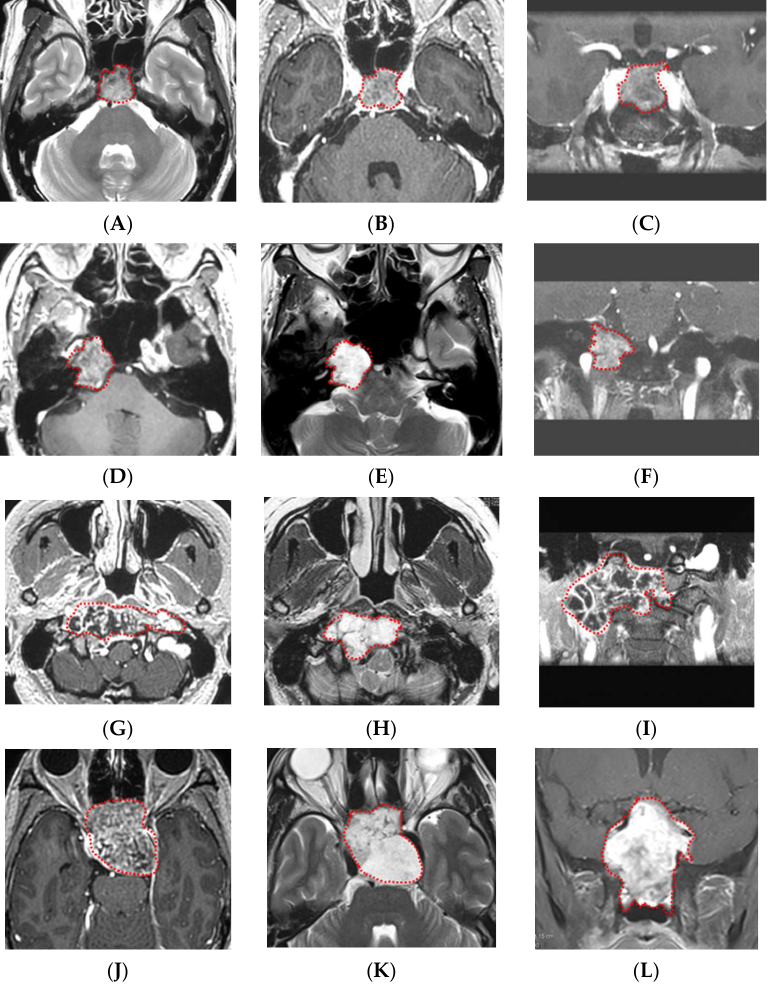
Figure 4. Representative cases of chordomas and chondrosarcomas. ( A – C ) GdT1, T2, and fsGdT1 coronal images of a typical chordoma case. The machine learning model correctly diagnosed the tumor, and high diagnostic accuracy (80%) by neurosurgeons was noted. ( D – F ) GdT1, T2, and fsGdT1 coronal images of a typical chondrosarcoma case. The machine learning model correctly diagnosed the tumor, and the highest diagnostic accuracy by the neurosurgeons (85%) was noted. ( G – I ) GdT1, T2, and fsGdT1 coronal images of the chordoma case with the correct diagnosis by the machine learning model but with low diagnostic accuracy by the neurosurgeons (40%). ( J – L ) GdT1, T2, and fsGdT1 coronal images of the chondrosarcoma case with the incorrect diagnosis by the best machine learning model and the lowest diagnostic accuracy by the neurosurgeons (20%). Abbrevi- ations: T2 weighted image—T2; post-gadolinium T1-weighted images—GdT1; fat suppression post- gadolinium T1-weighted images—fsGdT1. Red dotted lines indicates tumor. 4. Discussion Radiomics has been studied for the purpose of preoperative evaluation of histologi- cal diagnosis and tumor consistency in various neoplasms such as prostate cancer [16], lung cancer [18], and brain tumors including glioma [17,19–21], meningioma [27], and brain metastasis [28]. The radiographic characteristics are extracted as parametric data,